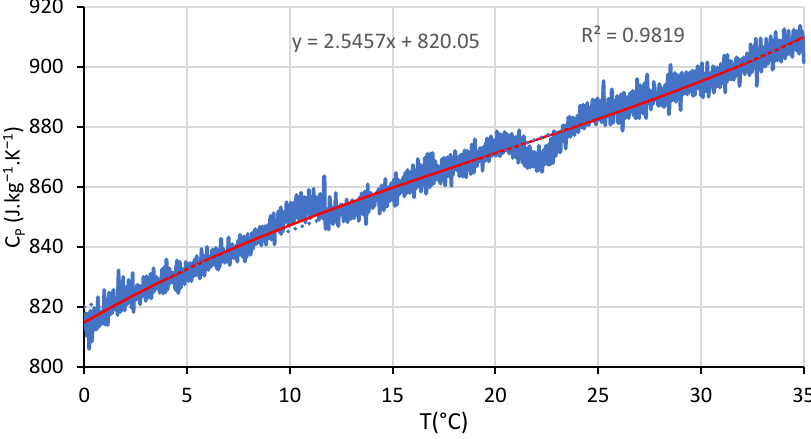
Figure 9. Specific heat capacity of cob in the range temperature exploited and linear fitting.